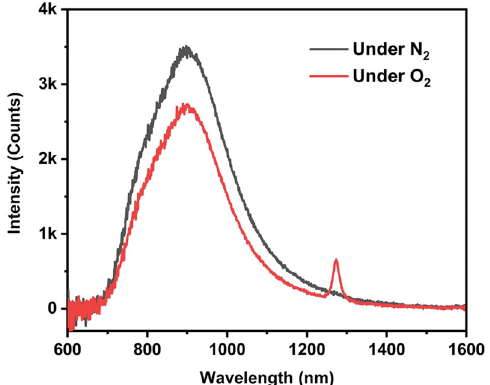
Fig. 2 PL spectrum of Au 38 (PET) 26 in deuterated chloroform under N 2 and O 2 , respectively. The sharp peak at 1272 nm is from the emission of singlet oxygen ( 1 O 2 , phosphorescence) due to sensitization of triplet 3 O 2 by the triplet state of Au 38 (PET) 26 after photoexcitation.